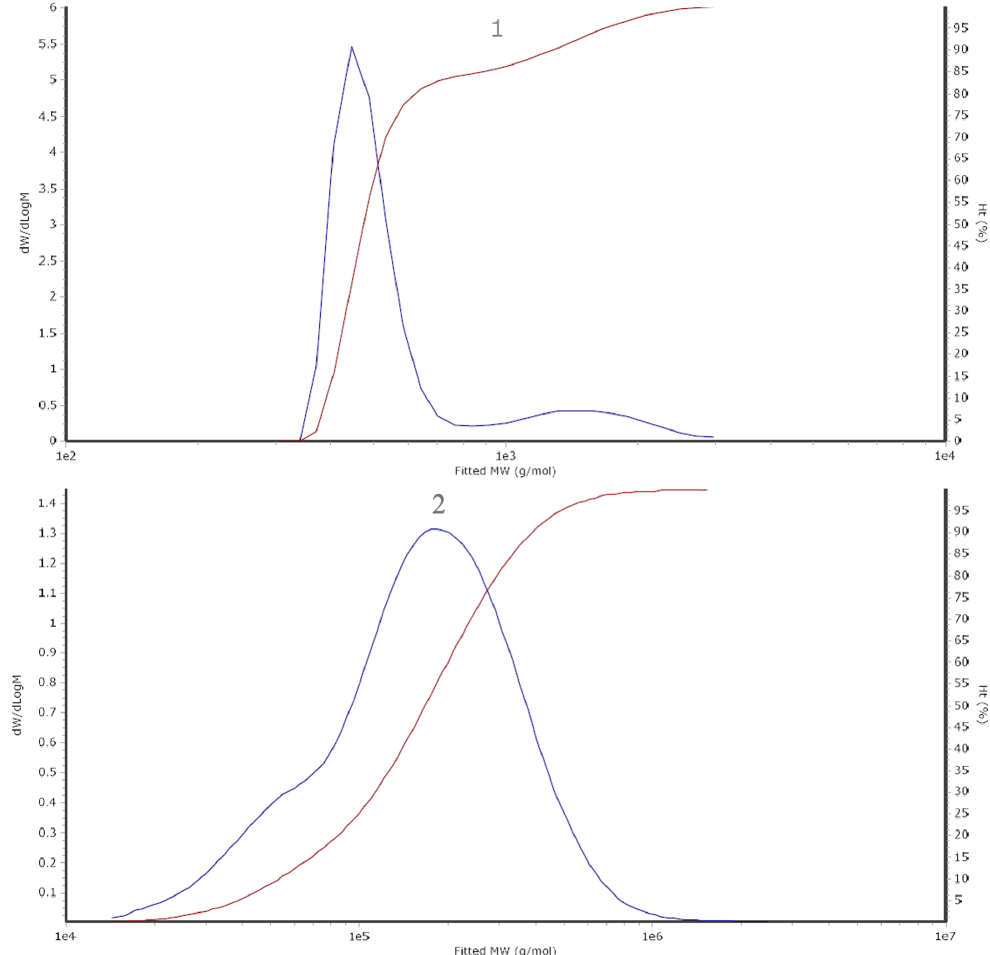
Figure A2. The molecular weight of malanto flavonoid extract; measurement results. Calculated molecular weight (blue line) . Detector: LS 90° (red line).